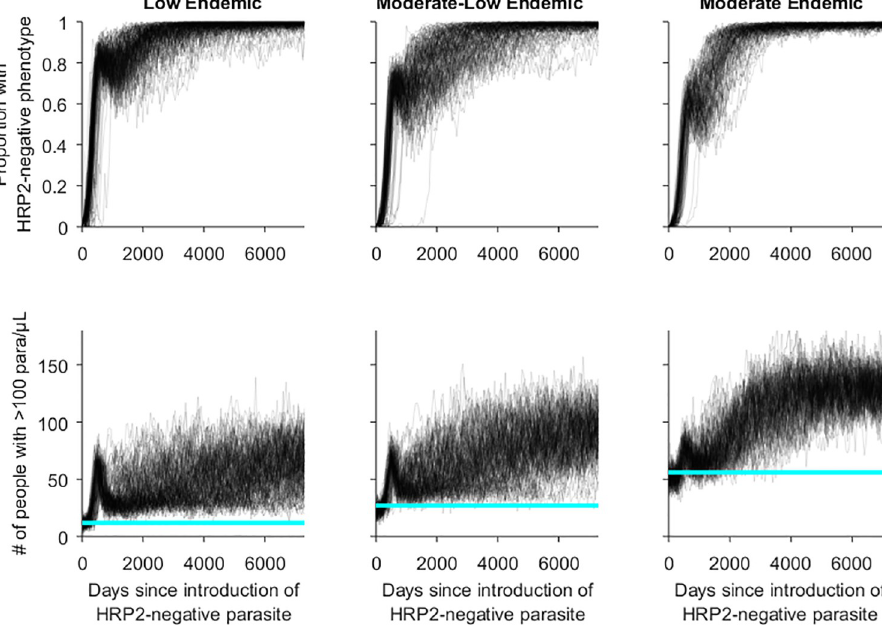
Fig 3. Simulation trajectories for the proportion of all asexual infections ( > 10 parasites/ μ L) with a HRP2-negative phenotype (top), and prevalence of asexual infections ( > 100 parasites/ μ L) (bottom) where 50% of symptomatic patients seek diagnosis and treatment using a HRP2-only RDT (Scenario 4). Horizontal reference line: 75 th percentile of prevalence in 500 days before introduction of HRP2-negative parasite.